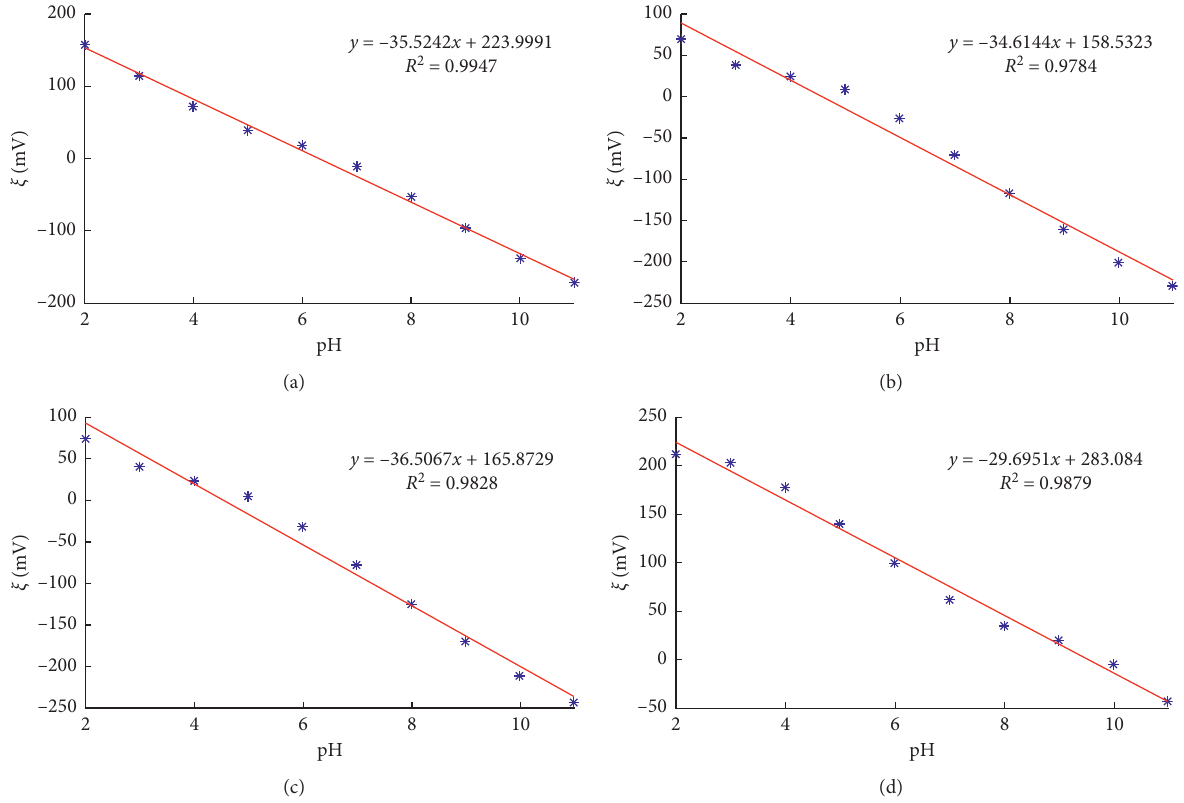
Figure 8: Total electrode potential ξ against pH for (a) TiO 2 , N s : 7 (anatase), ε s : 35, (b) Ta 2 O 5 , N s : 4, ε s : 50, (c) Ta 2 O 5 , N s : 6, ε s : 50, and (d) Al 2 O 3 , N s : 1.3, ε s : 10.43. The electrolyte is KCl for all